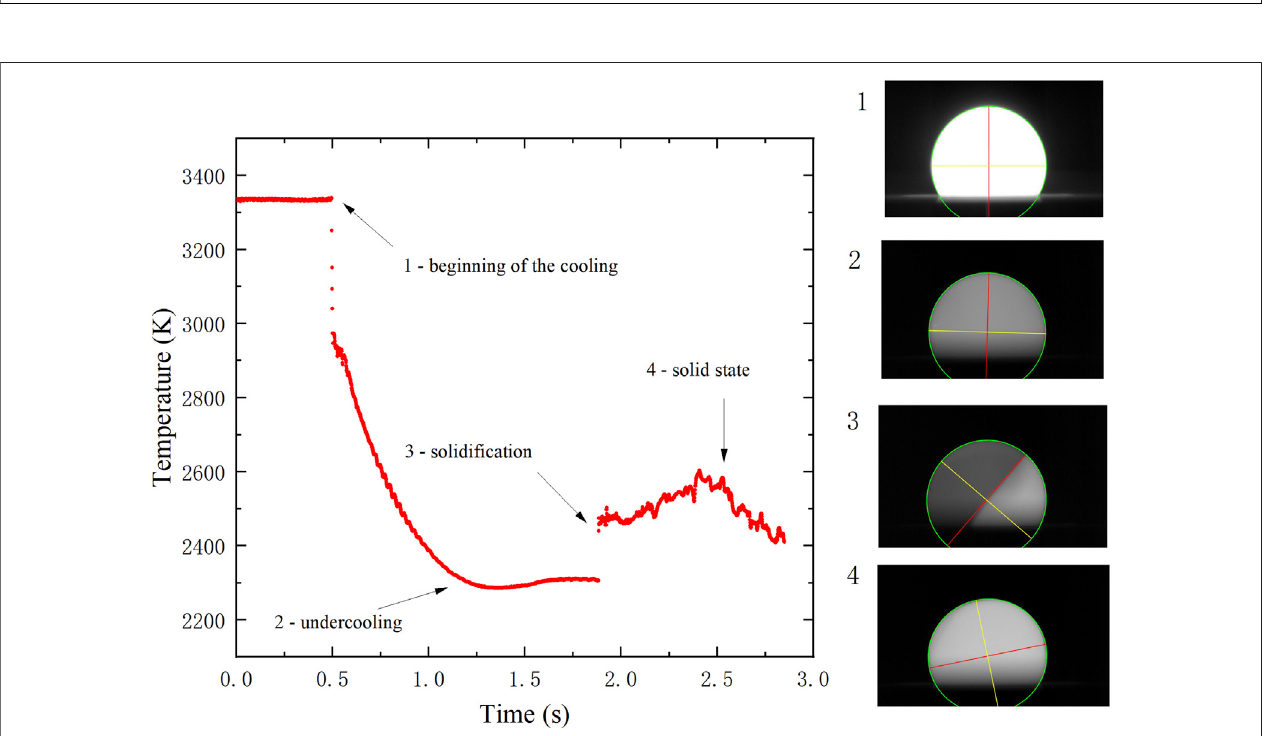
FIGURE 5 | Temperature history and images of an alumina sample during the cooling process induced by shutdown of the heating laser.